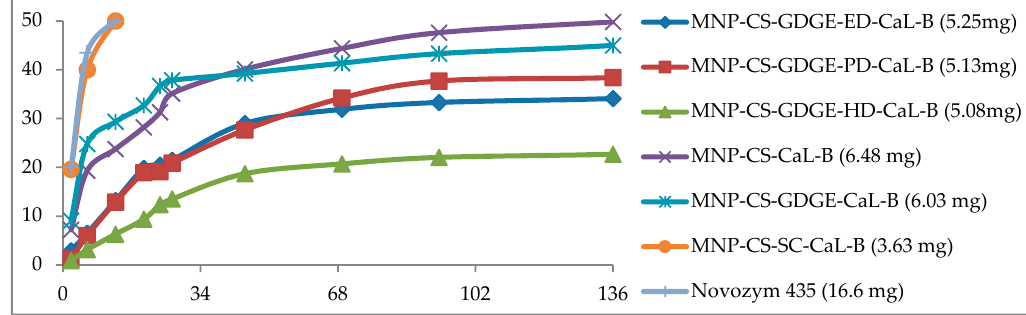
Figure 1. Biocatalyst screening in the EKR of rac - 2a .